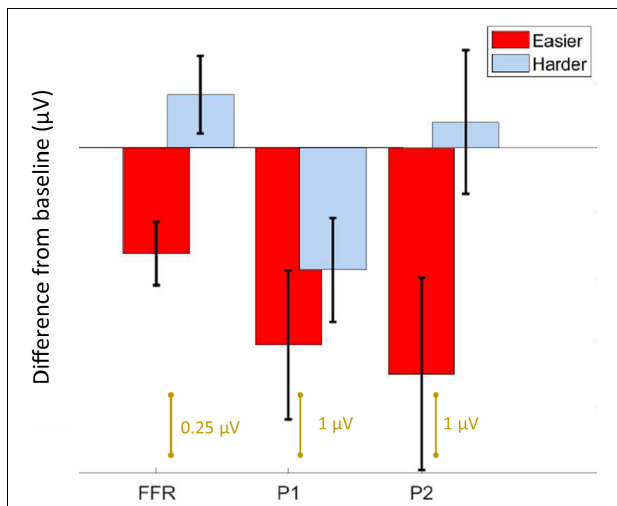
FIGURE 3 | Summary of results. Bar graph showing the average difference from baseline ± 1 standard error of the mean for the FFR, P1, and P2 components. For the easier condition, both the brainstem and cortical components are reduced from baseline, whereas for the harder condition, only P1 is different. Note the FFR is smaller in amplitude than the cortical components, and is plotted on a different